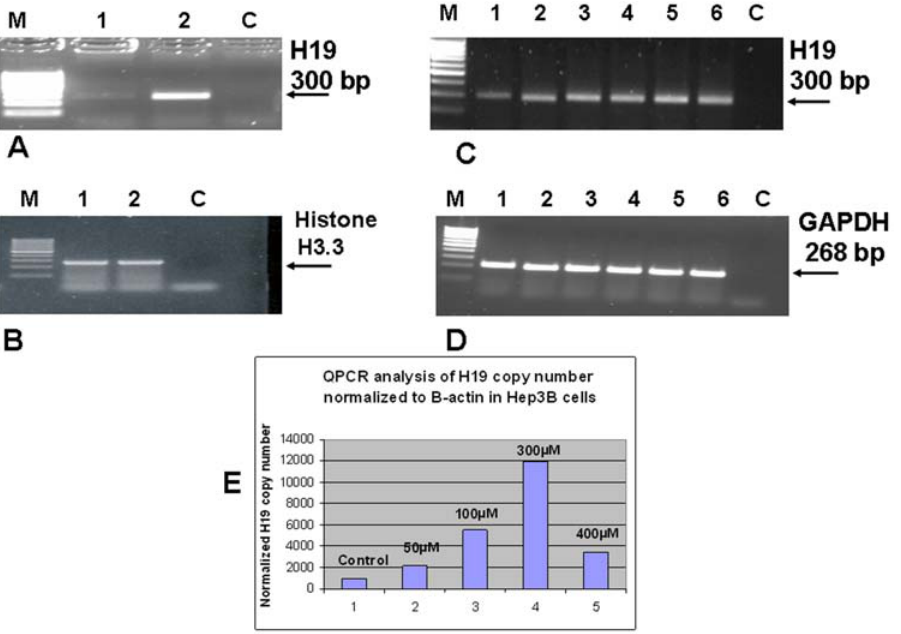
Figure 1. H19 RNA is largely induced in response to hypoxic stress and moderately by hypoxia-mimicking condition triggered by CoCl 2 in Hep3B. Hep3B cells were cultured under normal culture conditions for 24 hours before hypoxic or CoCl 2 manipulation. Cells were either placed into an aneoropack rectangular jar to create a hypoxic condition within an hour, or left under normal culture conditions. Incubation lasted for 24 hours before RNA extraction. (A) Shown are RT-PCR products of H19 gene (28 PCR cycles) cultured under normal conditions-lane 1, or hypoxic conditions- lane 2 (lane M indicates the marker, and C is a PCR blank without a target). (B) PCR for Histone H3.3 as a positive control for RT-PCR integrity. Shown also are RT-PCR products of both the H19 gene (32 PCR cycles) (C), the GAPDH gene (D) for untreated Hep3B (lane1) and for 50, 100, 200, 300 and 400 m M CoCl 2 treated cells (lanes 2, 3, 4, 5 and 6, respectively). Incubation with the indicated concentrations of CoCl 2 lasted for an additional 22 hours before RNA extraction. QPCR analysis for H19 RNA levels normalized to b -actin in Hep3B treated CoCl 2 is shown in (E) where the numbers above the bars indicate the concentrations of CoCl 2 used.